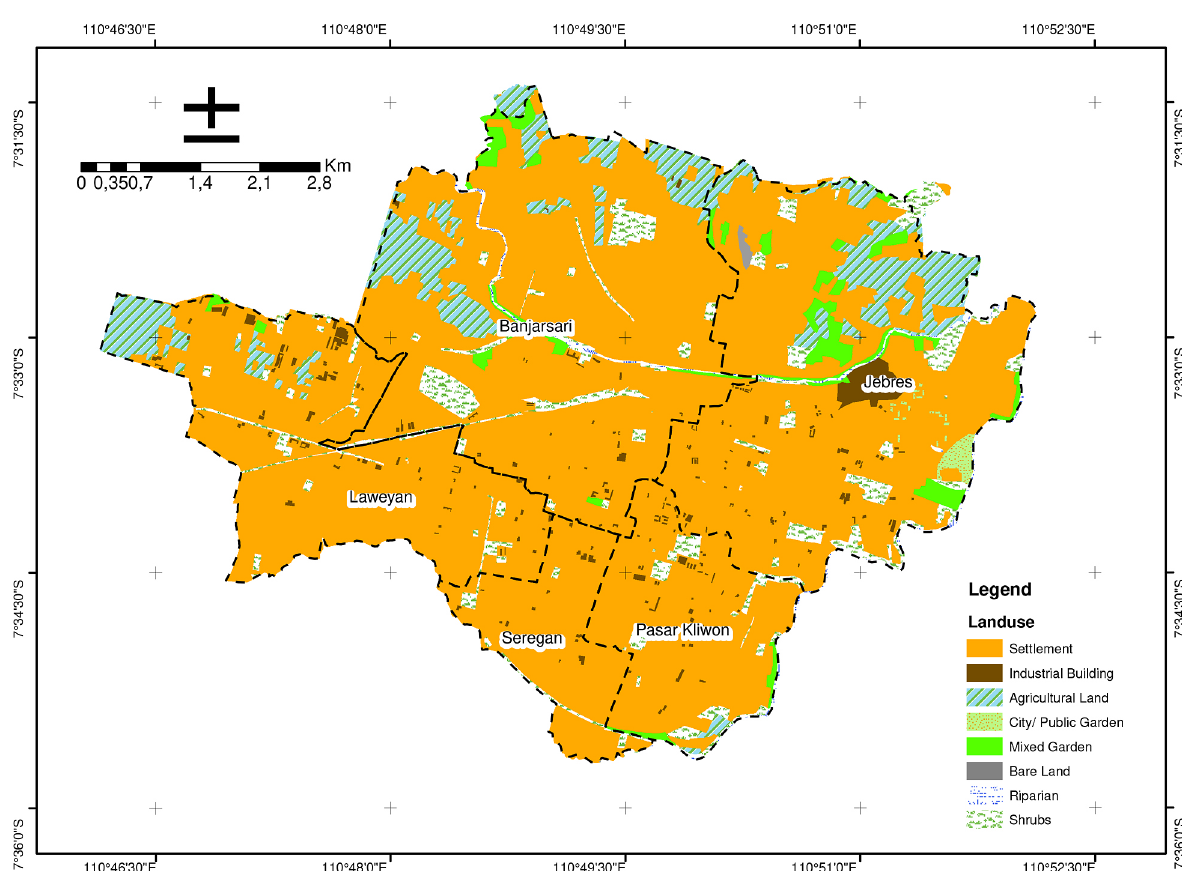
Fig. 2. landuse map in Surakarta